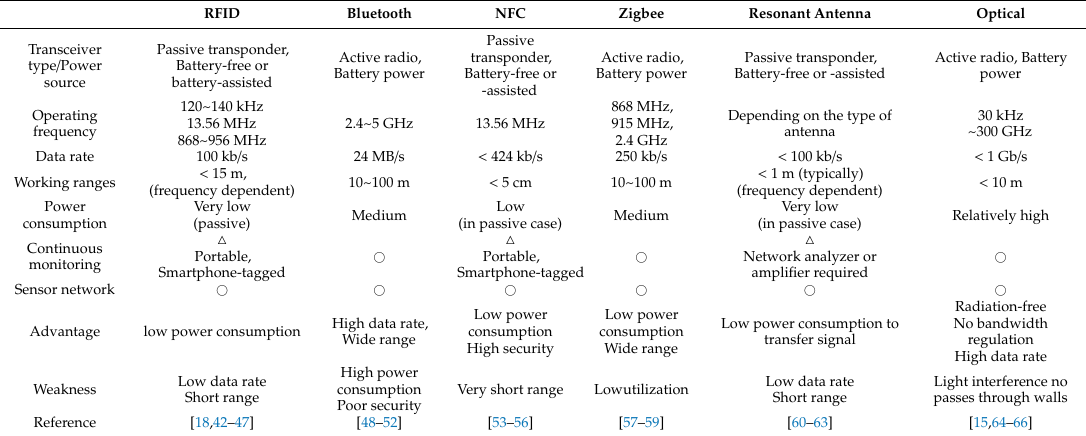
Table 1. Comparison of wireless data communication technologies used in wireless sensor